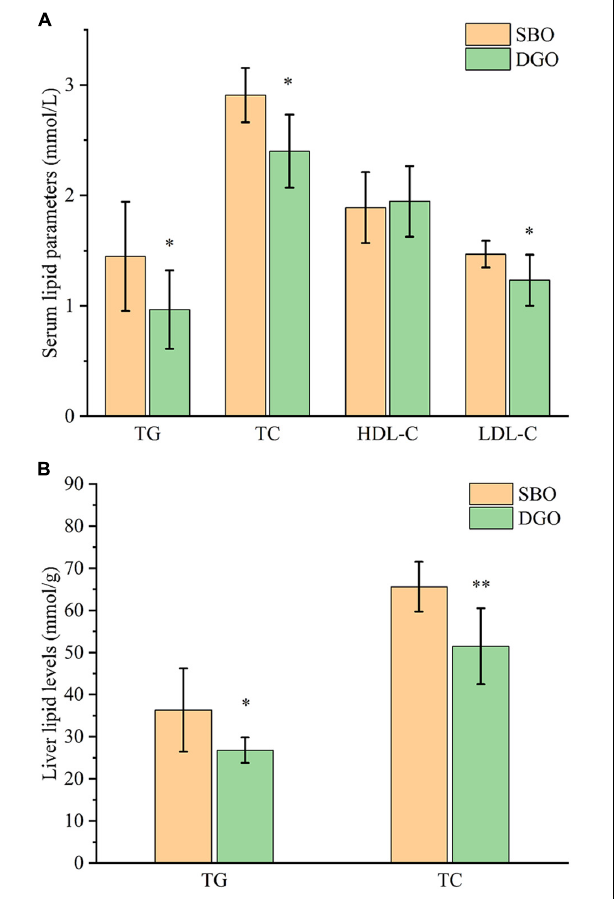
FIGURE 5 | Effects of DAG-enriched oil on serum (A) and liver (B) lipid levels in fish. ∗ and ∗∗ indicate significant differences between the SBO and DGO groups at P < 0.05 and P < 0.01, respectively. TG: total triglyceride, TC: total cholesterol, HDL-C: high-density lipoprotein cholesterol, LDL-C: low-density lipoprotein cholesterol, SBO: soybean oil, DGO: DAG-enriched oil.